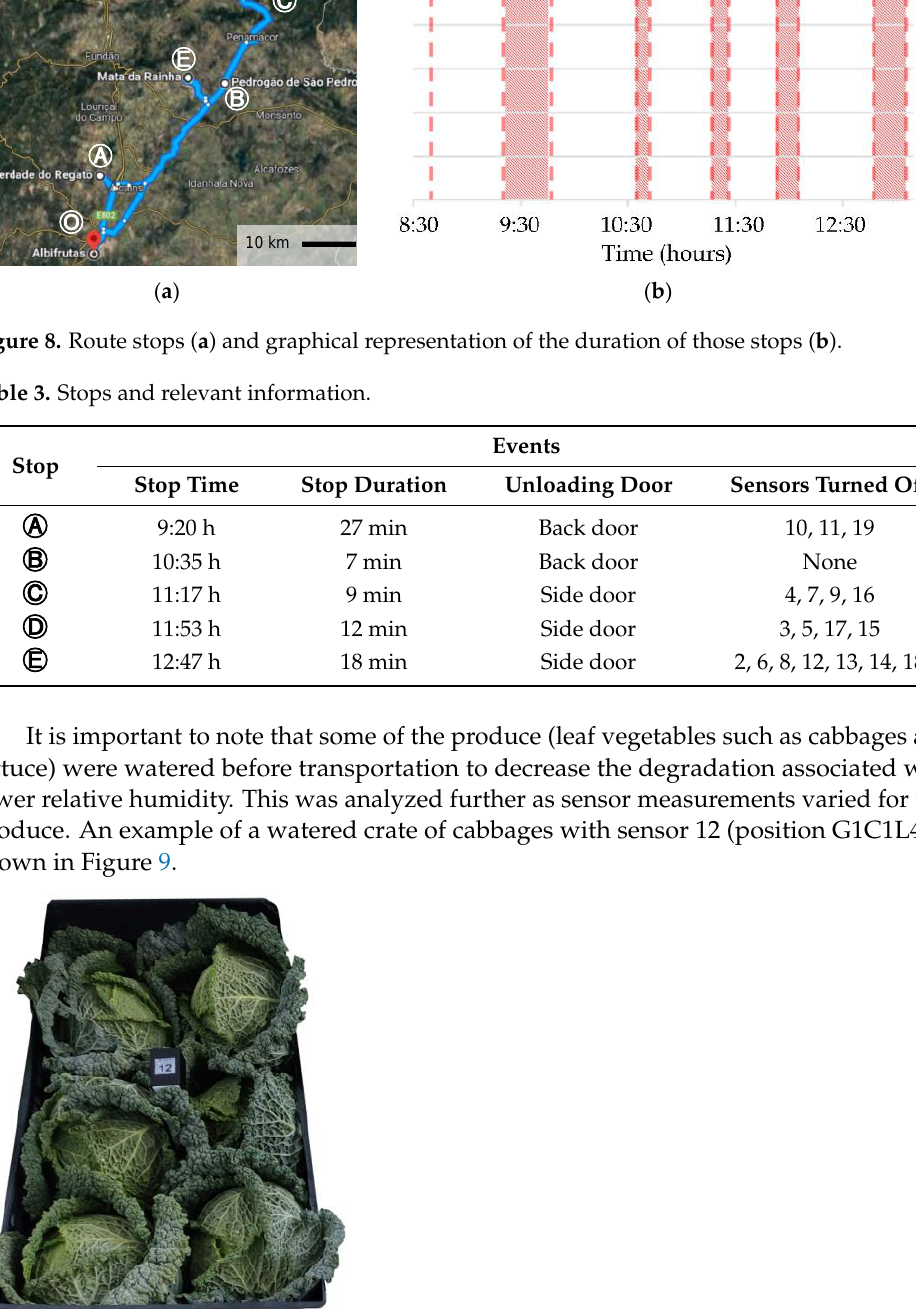
Figure 9. Crate with cabbages that were watered prior to loading in the truck.